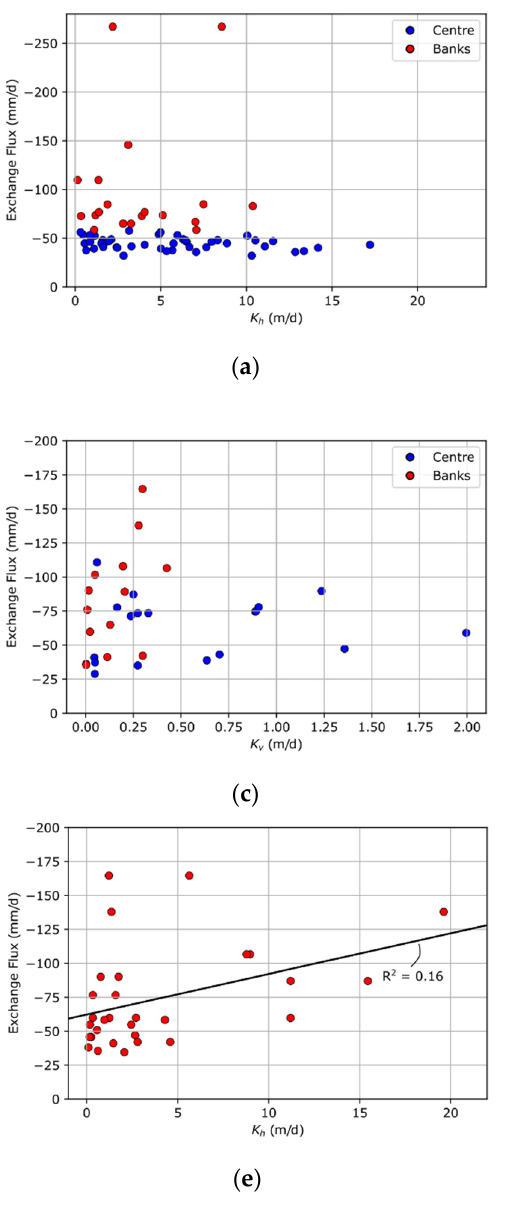
Figure 6. Cross-plots of estimated river-aquifer exchange fluxes and ( a ) 𝐾 (cid:3035) at the downstream section; ( b ) 𝐾 (cid:3035) at the upstream section; ( c ) 𝐾 (cid:3049) at the upstream section; ( d ) 𝐾 (cid:3049) near the banks at the upstream section ( 𝑅² = 0.29 ); ( e ) 𝐾 (cid:3035) near the banks at the upstream section ( 𝑅² = 0.16 ); and ( f ) 𝐾 (cid:3029)(cid:3028)(cid:3041)(cid:3038) at the downstream section ( 𝑅² = 0.26 ).